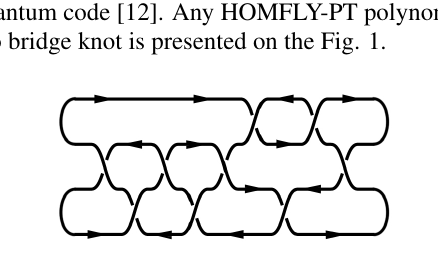
Figure 1. Typical plat representation for the knot (it is a two-bridge case: there are two arcs at the left and at the right). This concrete knot is 9 14 in the Rolfsen table